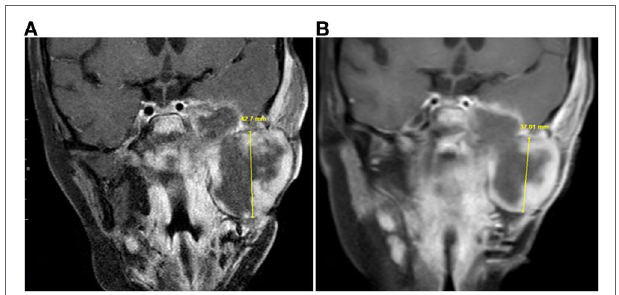
FIGURe 1 | Magnetic resonance imaging (MRI) taken prior to and during vorinostat treatment. Coronal contrast-enhanced T1-weighted MRI images from (a) July 2014 and (b) September 2014 showed decrease in size of the infratemporal component of the tumor. Craniocaudal measurement showed the greatest change, although this component of the tumor had decreased in size in other dimensions as